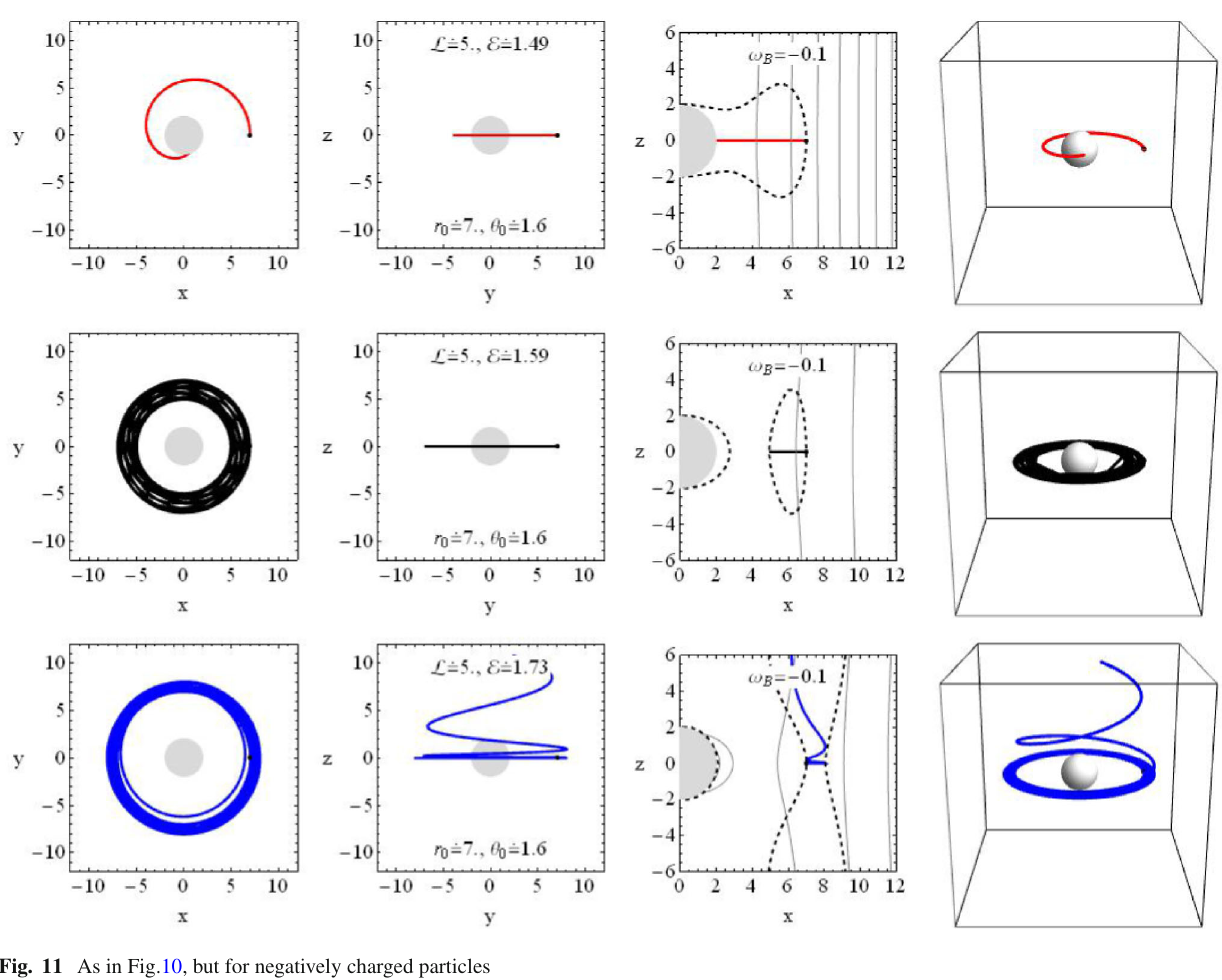
Fig. 11 As in Fig.10, but for negatively charged particles